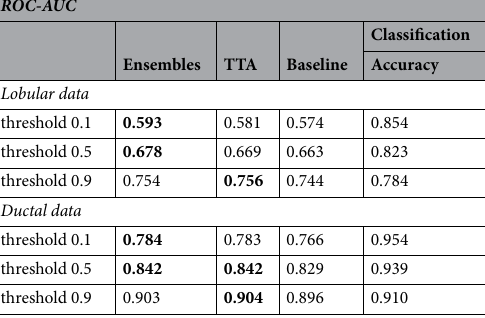
Table 7. ROC-AUCs of misprediction detection by sample means uncertainty computed from ensembles and TTA methods. The highest achieved values per classification threshold are in